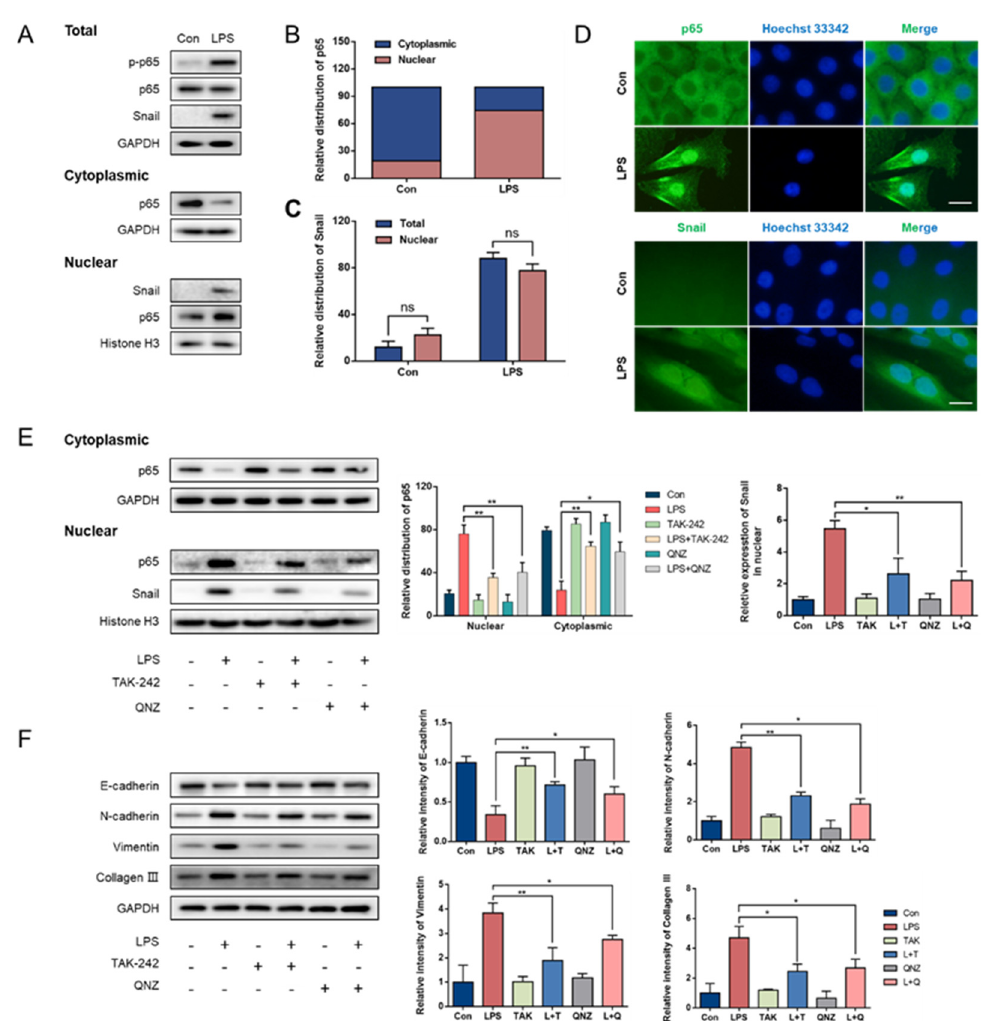
Figure 3. Snail expression required p65 nuclear translocation in GMECs. ( A ) Expression of p65 and Snail inside and outside the nucleus after LPS treatment for 14 d. (original western blot figures in Figure S5). ( B ) Relative distribution of p65 in nuclear proteins and cytoplasmic proteins. ( C ) Relative distribution of Snail in nuclear proteins and total proteins. ( D ) Immunofluorescence staining showed the localization of p65 and Snail. ( E ) p65 and Snail protein expression inside and outside the nucleus after inhibition of the TLR4/NF- κ B signaling pathway. (original western blot figures in Figure S6). ( F ) Protein expression of EMT markers after TLR4/NF- κ B inhibition. (original western blot figures in Figure S7). * Indicates significant difference between two groups, * p < 0.05, ** p < 0.01. Scale bar = 20 μ m.